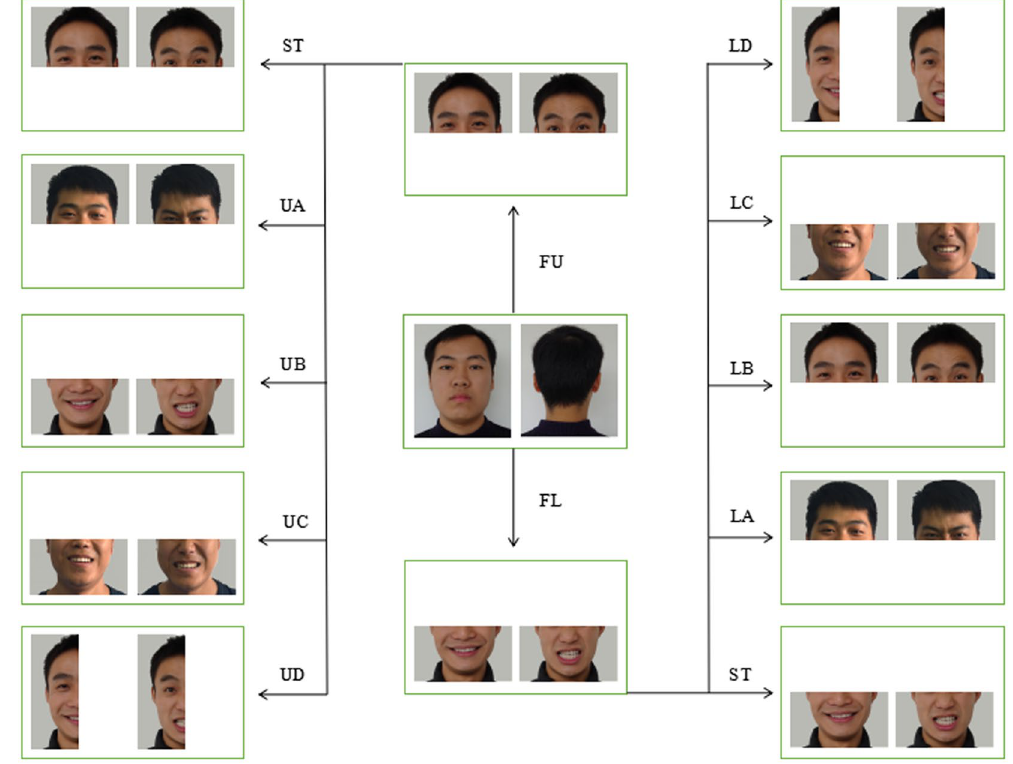
Figure 4. Some pictures used as stimulus pairs in this study. All pictures were of the faces of adult Chinese men, and the pre-training stimuli and test stimuli were pictures of members of our laboratory. Shown are example stimulus pairs in the pre-training set and the two first-stage sets as well as example stimulus pairs in the probe trials for a subject trained with the upper or lower halves of the faces (left and right columns, respectively). All picture pairs have been reproduced with the permission of the depicted person. FU: first stage trial in upper group; FL: first stage trial in lower group; ST: standard trial; UA: same portion, novel face in upper group; UB: other horizontal half, same face in upper group; UC: other horizontal half, novel face in upper group; UD: left half (vertical), same face in upper group; LA: same horizontal portion, novel face in lower group; LB: